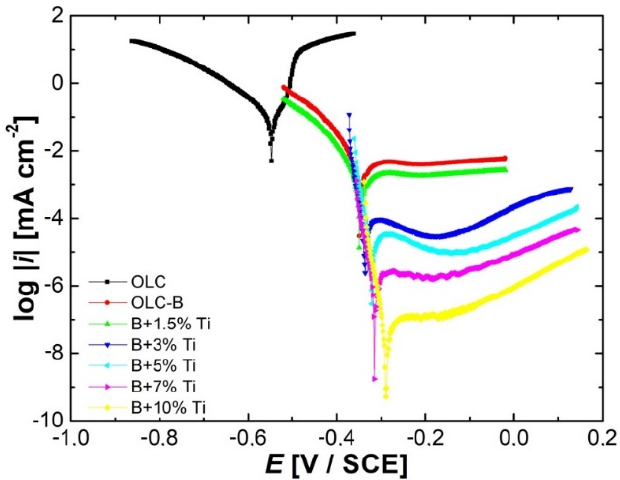
Figure 6. Tafel plots recorded at 1 mV/s scan rate for mild steel without and with NiCr(Ti) coatings test samples recorded in test solution.